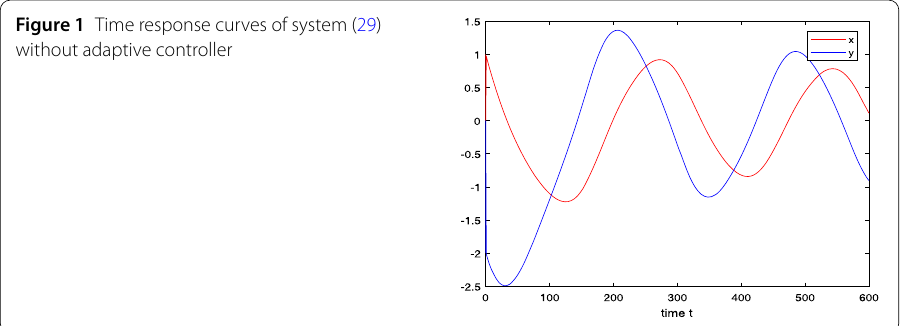
Figure 1 Time response curves of system (29) without adaptive